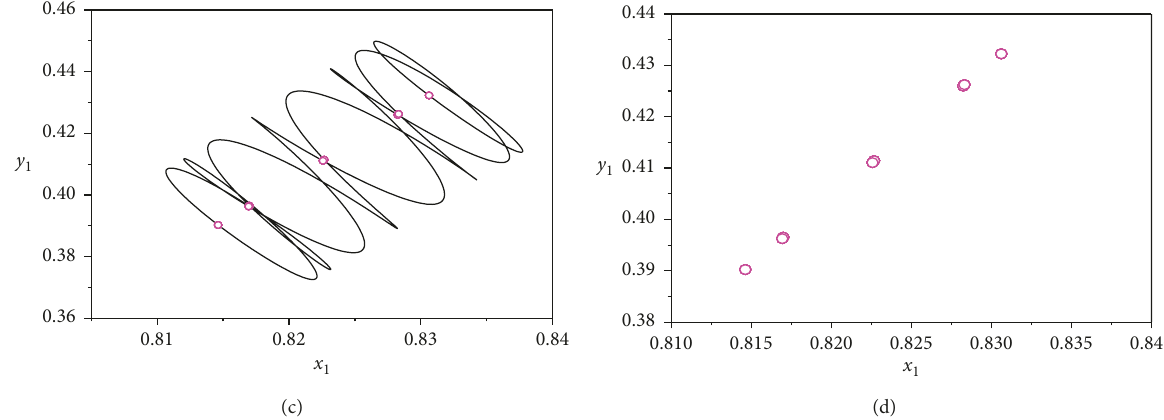
Figure 4: ω � 1.210: (a) displacement response; (b) frequency spectrum; (c) rotor orbit; (d) Poincar´e maps.